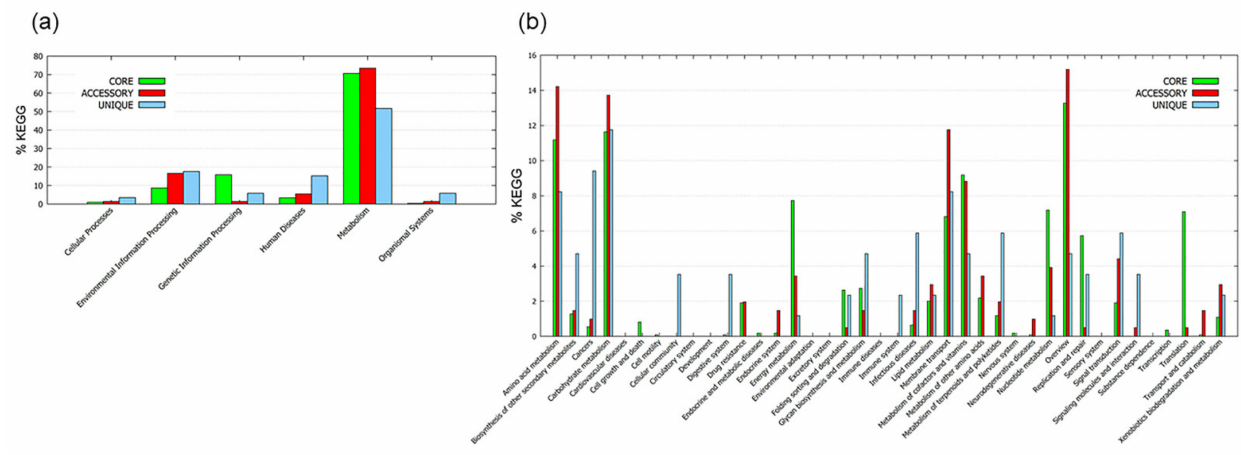
Figure 3. KEGG distribution of core, accessory and unique genes. ( a ) Distribution in major category. ( b ) Distribution in